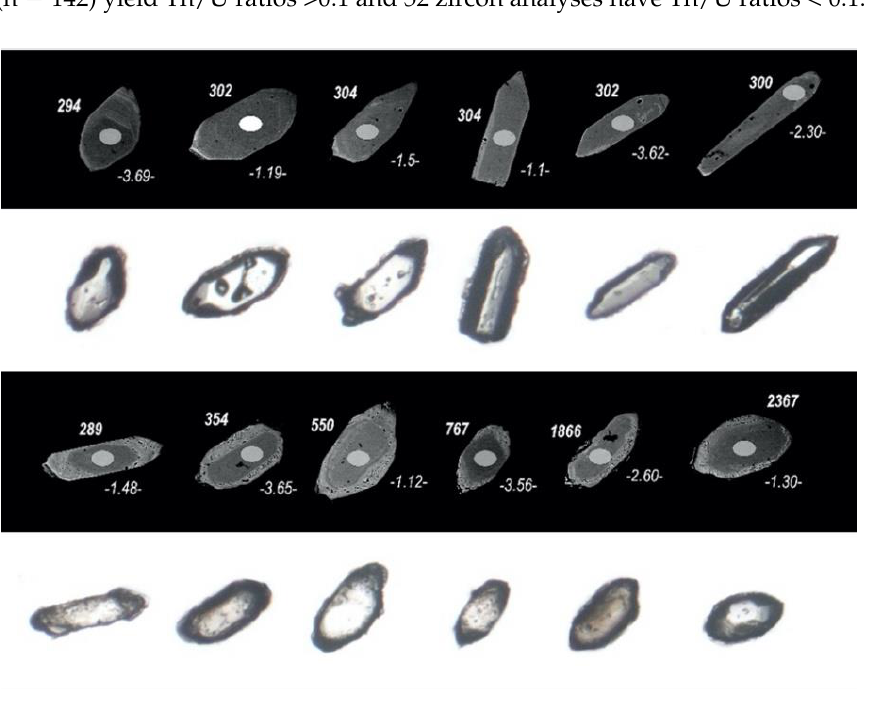
Figure 8. BSE images and optical photomicrographs of analysed zircons from tb-07-845 sample (migmatite). Ellipses mark analytical spot locations and the text shows spot names (italics) and 208 Pb/ 236 U age in Ma (bold). 5.3. Sample Gu-35-2 (Hoyo Del Bote Migmatite) One hundred and seventy-five zircons were analysed by LA-ICP-MS. As in the Istan migmatite sample, the analysed zircon crystals are idiomorphic and display mainly bi- pyramidal morphologies (Figure 9). Single and composite core – rim structure zircons are observed. The crystals with composite structure have eroded and resorbed cores and sometimes are overgrown by a light and thin rim. Due to their thinness these rims could not be dated by LA-ICP-MS. Measured Th/U ratios are in between 2.4 and 0.01. Most zir- cons display Th/U ratios >0.1 (n − 128) and only 13 zircon analyses have Th/U ratios < 0.1 (Figure 5). Age distribution patterns (Figure 6c) from 192 to 3019 Ma show that 79% of the ana- lysed zircons are Precambrian in age and mostly yield Neoproterozoic (55%; ca. 543 – 1000 Ma) and Paleoproterozoic (18%; ca. 1.6 – 2.4 Ga) ages, with the rest being Mesoproterozoic (4%; ca. 1.0 – 1.6 Ga) and Archean (2%; ca. 2.5 – 3.0 Ga). The remaining analyses give Paleo- zoic (19%; ca. 278 – 524 Ma) or Mesozoic (2%; ca. 192 – 206 Ma) ages. Two main populations can be peaked at 585  3 Ma (n − 9) and 978  7 Ma (n − 5). Th/U analyses with values <0.1 mainly come from the zircon population aged at 585  3 Ma (Figure 7).